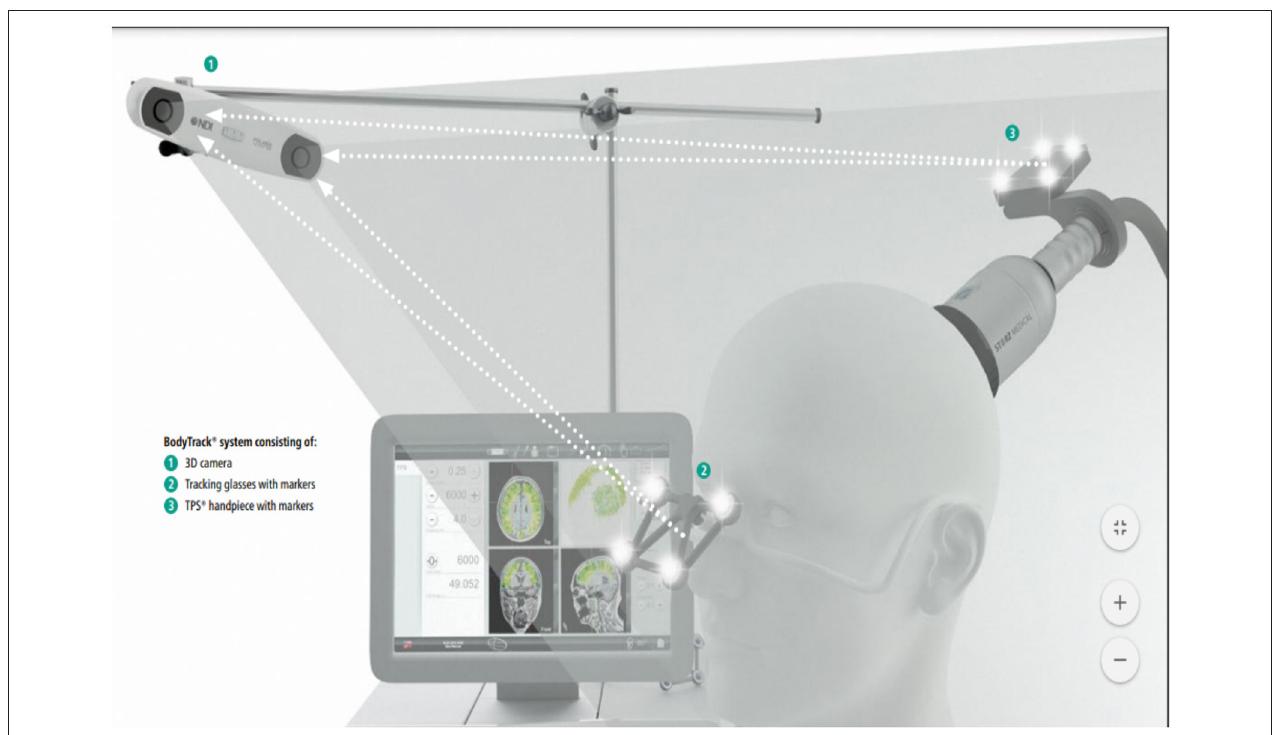
FIGURE 1 | Courtesy image from NEUROLITH-TPS manufacturer.